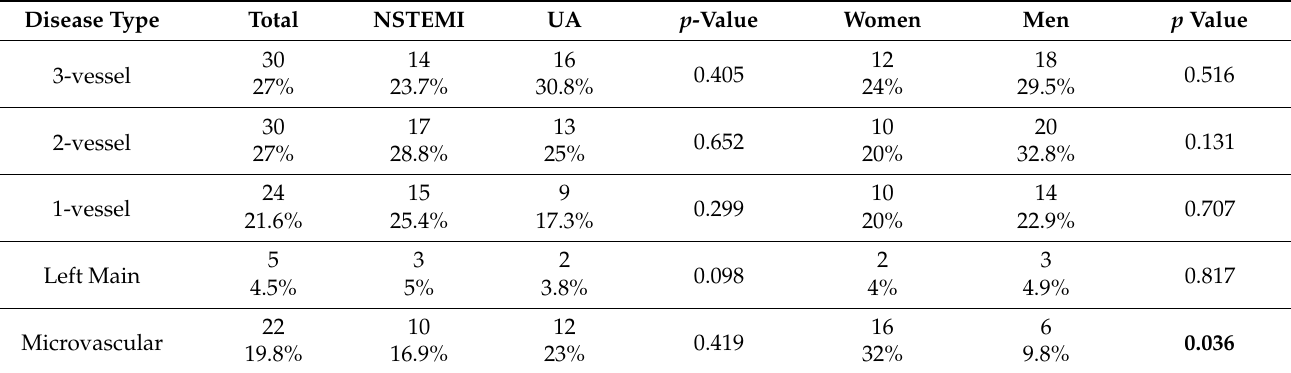
Table 3. Coronary angiography results and Chi-square test results.